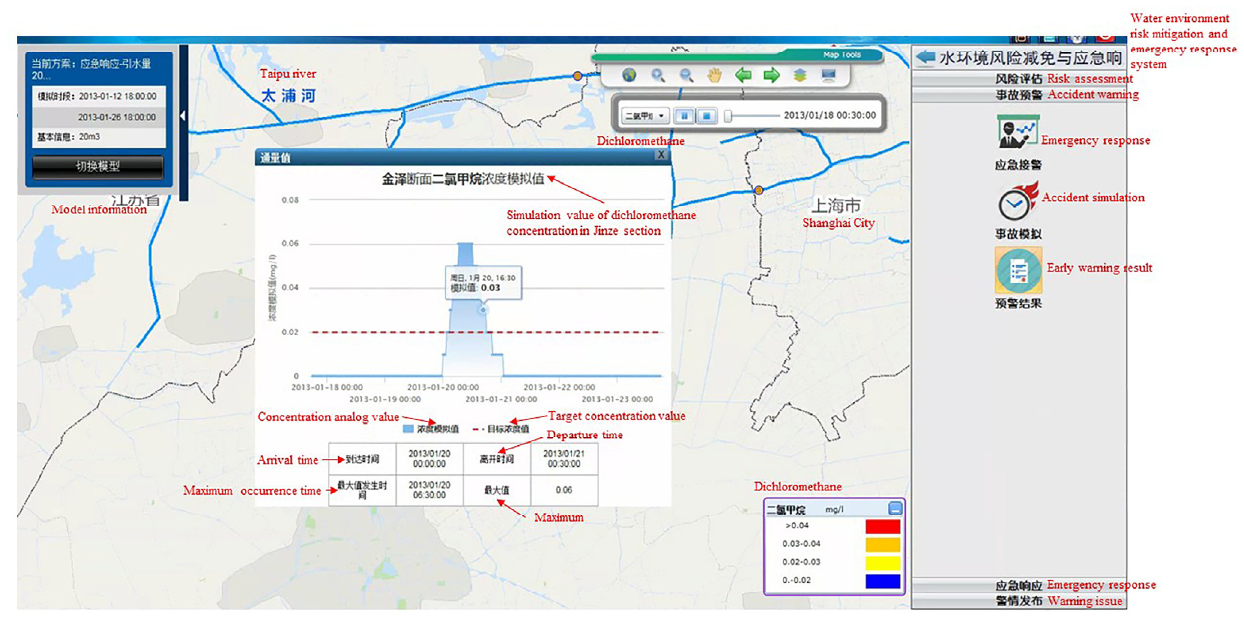
Figure 13. Simulated pollutant concentration values for a pollution accident in the Suhu trans- boundary area of the Taipu River.